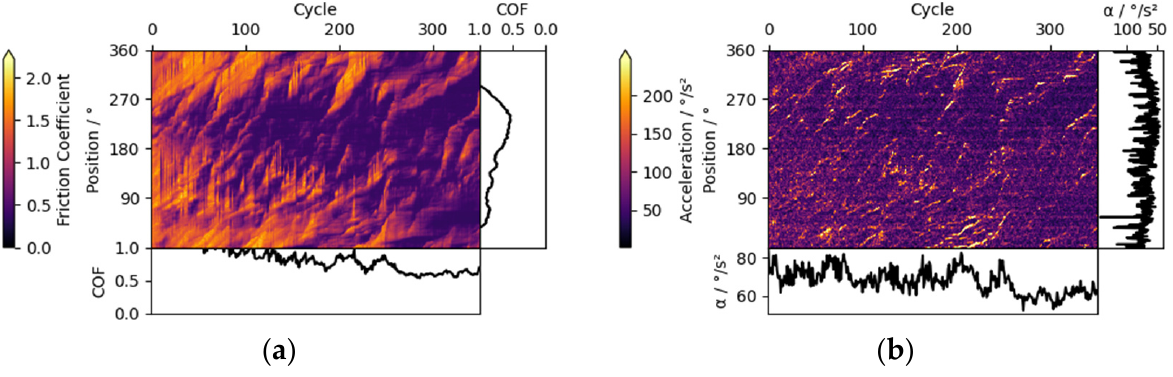
Figure 8. Triboscopic image for a ta-C 3 coating vs. a ta-C 1 counter body in a nitrogen atmosphere. ( a ) Friction triboscopic image. ( b ) Acceleration triboscopic image.